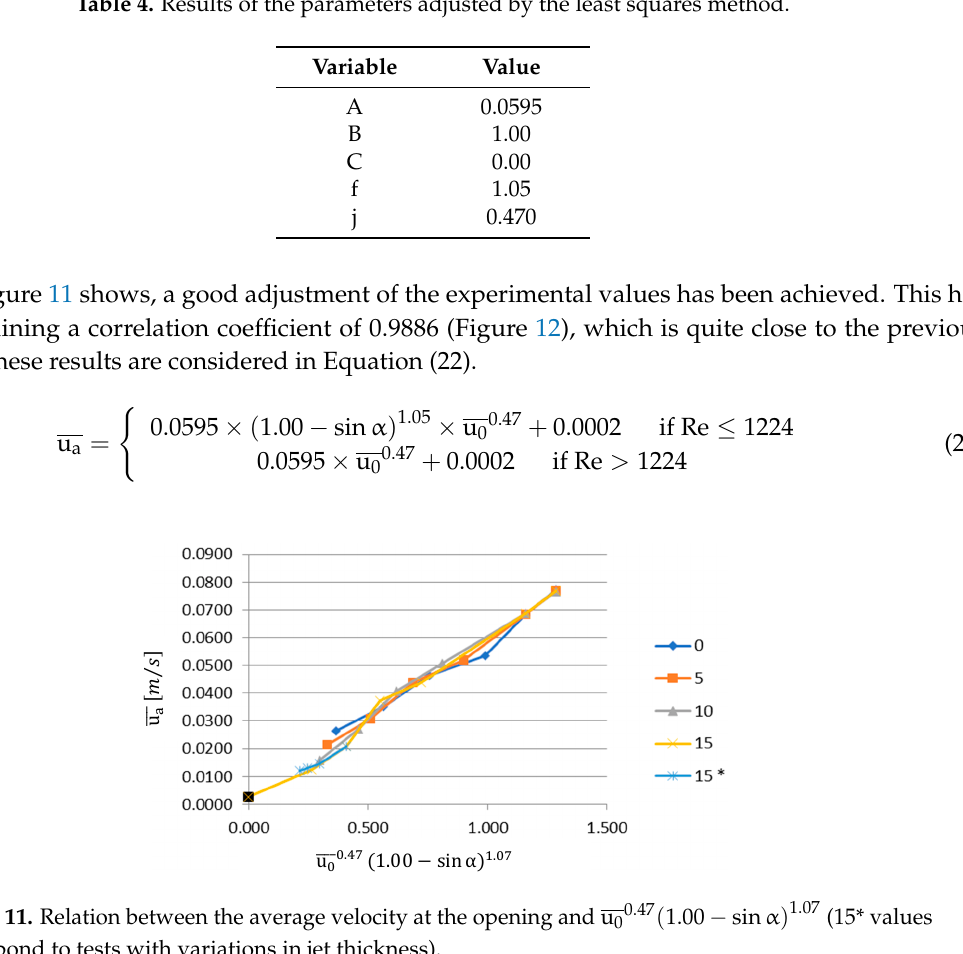
Figure 11. Relation between the average velocity at the opening and u (cid:2868) (cid:3364)(cid:3364)(cid:3364) (cid:2868).(cid:2872)(cid:2875) (cid:4666)1.00 (cid:3398) sinα(cid:4667) (cid:2869).(cid:2868)(cid:2875) (15* values correspond to tests with variations in jet thickness).